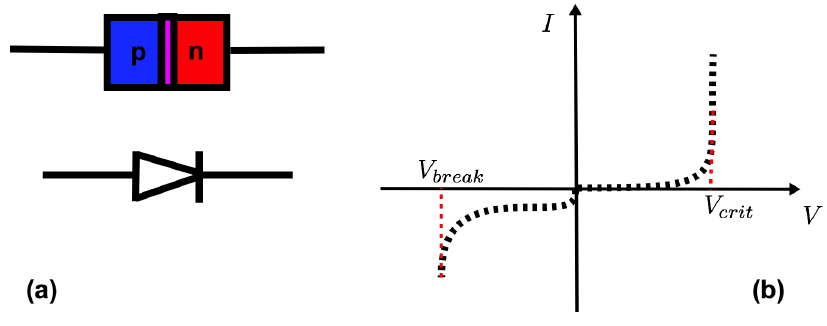
Figure A3. The pn-junction. ( a ) the pink region is the charge exchange region for the doped and undoped region; ( b ) a stylized response in voltage of a diode. In many ways, the shape resembles the nonlinearity which occur in nonlinear memristors in which field effects become